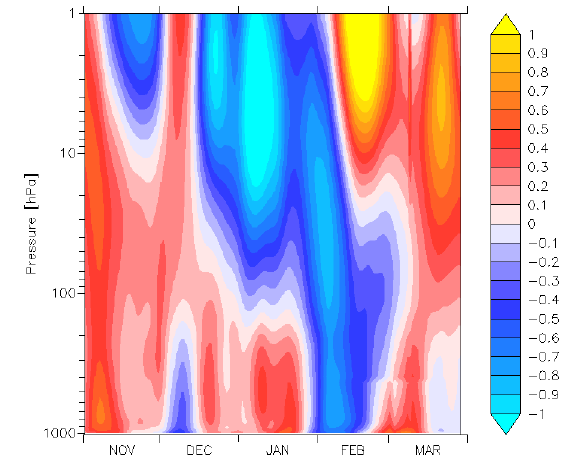
Fig. 10. Climatological change of geopotential height anomalies (normalised at every level with respect to standard deviation) for the region 60 ◦ N–90 ◦ N, ∆ Z = Z S − EPP − Z S − noEPP . Red-yellow/blue colours indicate positive/negative differences.